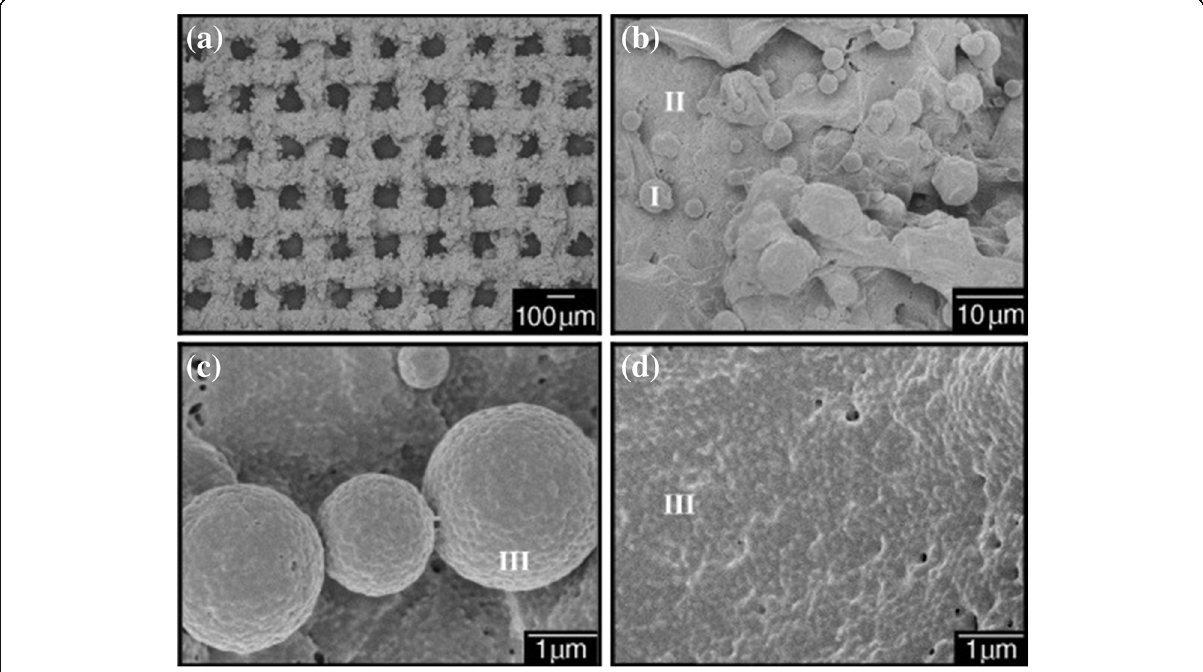
Fig. 2 Scanning electron microscopy (SEM) images of the coating mesh film prepared from a stainless steel mesh with an average pore diameter of about 115 μ m [11]. a Large-area view of the coated membrane [11]. b – d Enlarged view of the surface microstructure of the coated membrane